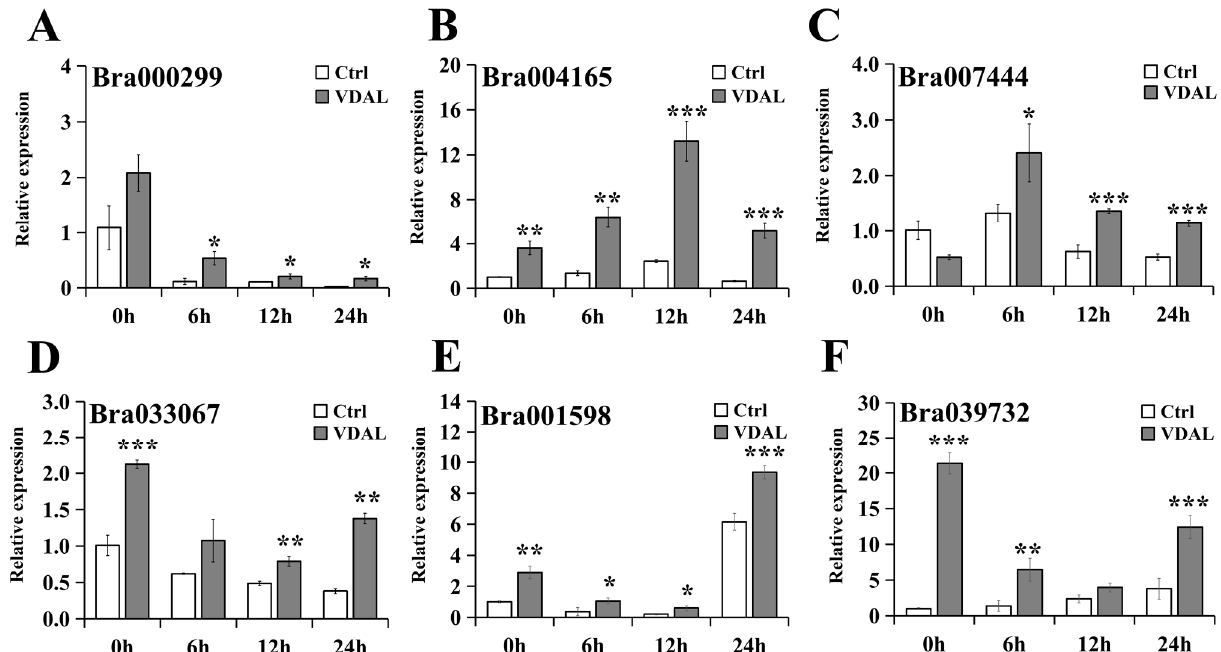
Figure 9. Expression levels of B. rapa defense ‐ related genes relative to the control. B. rapa leaves were sprayed with water or 1 g ∙ L − 1 VDAL. Shown are the relative expression levels of the Bra000299 ( A ), Bra004165 ( B ), Bra007444 ( C ), Bra033067 ( D ), Bra001598 ( E ), and Bra039732 ( F ) genes at 0, 6, 12, and 24 h after inoculation. Three independent replicates were performed. Student’s t ‐ test (* p < 0.05; ** p < 0.01; *** p < 0.001) was used to estimate significant effects.